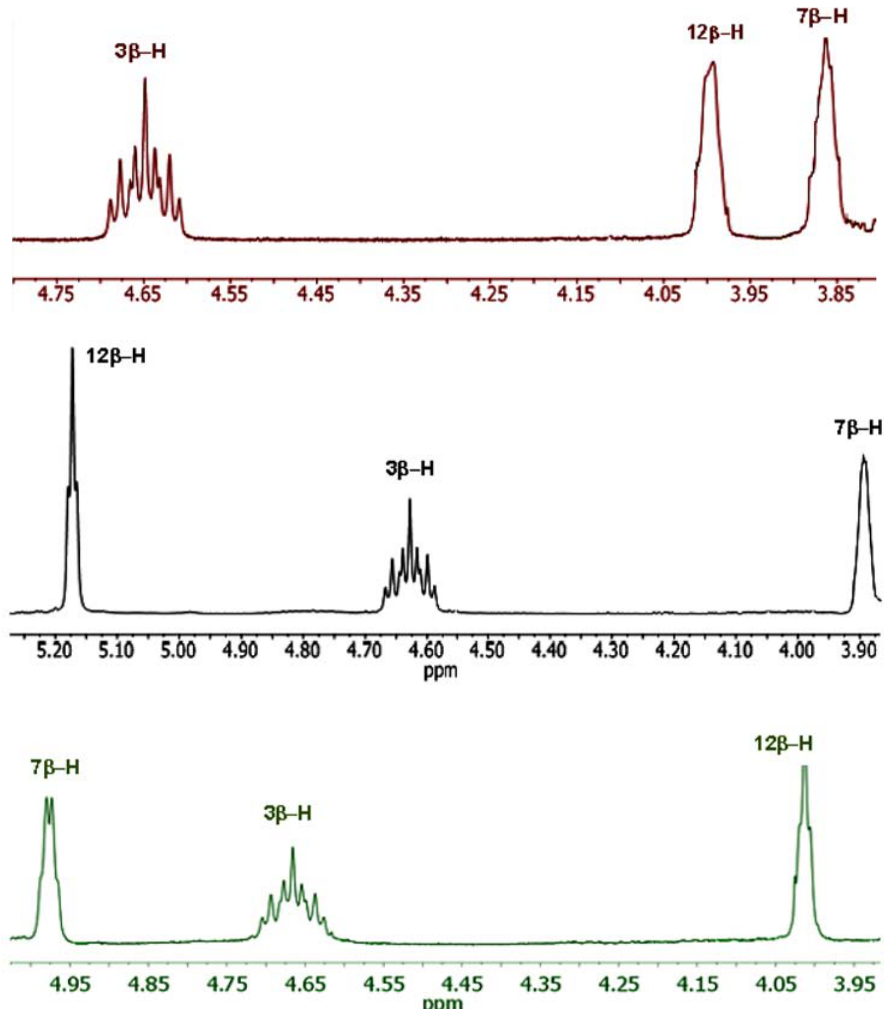
Figure 4. 1 H NMR spectra in the 5.20–3.80 ppm region showing the most characteristic signals of compounds 7 (red), 8 (black) and 9 (green).